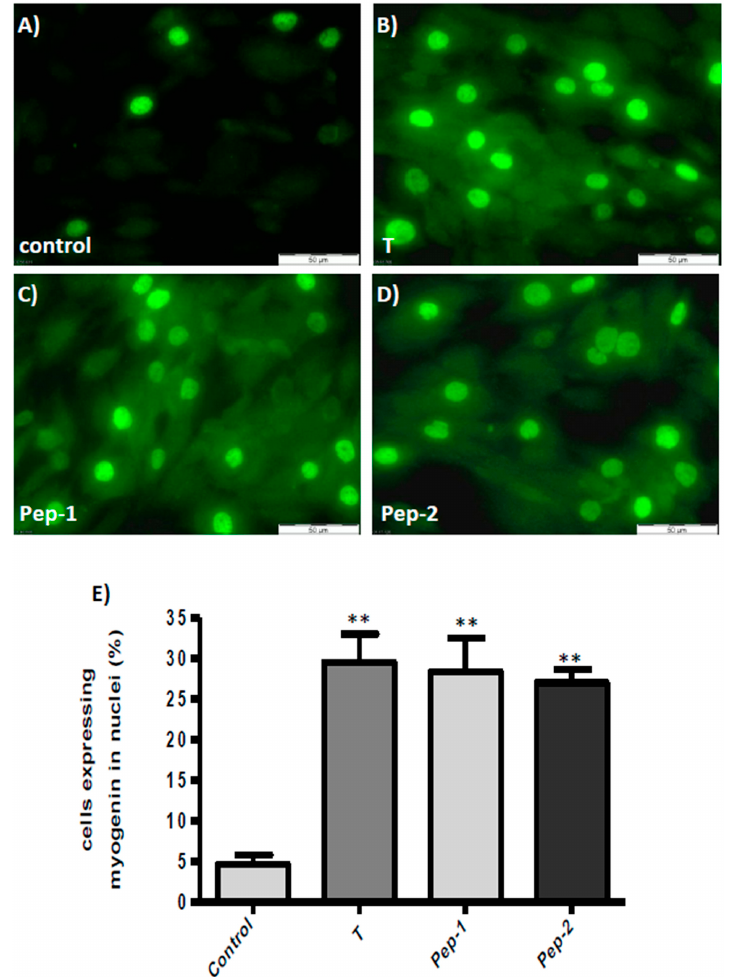
Figure 4. Detection of myogenin in L6 cells by immunofluorescence. DAPI blue staining of nuclei is not shown in order to avoid interference with the green fluorescence staining of myogenin. ( A ) Detection of myogenin in control cells. ( B ) Detection of myogenin in nuclei and cytosol of cells treated with testosterone. ( C ) Detection of myogenin in nuclei and cytosol of cells treated with Pep-1. ( D ) Detection of myogenin in nuclei and cytosol of cells treated with Pep-2. ( E ) Quantitative analysis showing the number of green-stained nuclei as % of the total nuclei present in the optical field. While not all nuclei were stained green, green fluorescence was visible within the cytosol of each individual cell that had been exposed to testosterone, Pep-1, or Pep-2, indicating stimulation of its expression by the three androgenic compounds. ( n = 3 ± SEM; ** p ≤ 0.001).